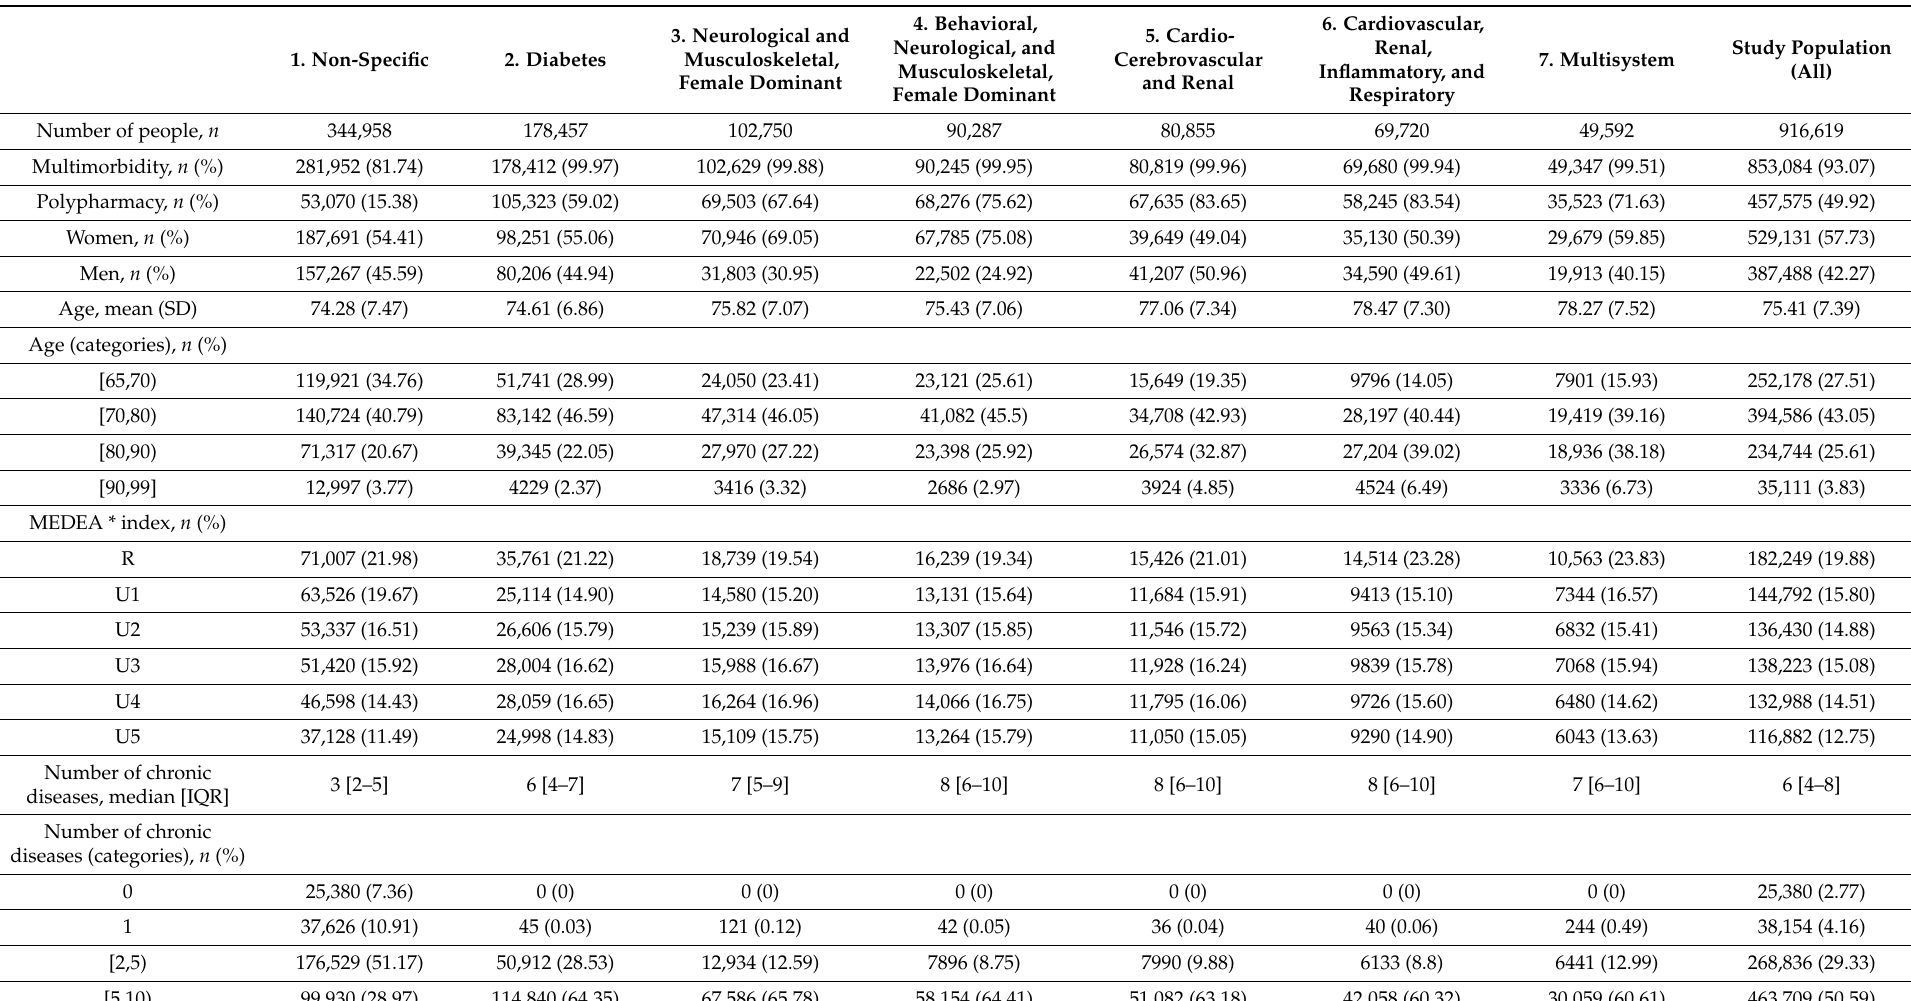
Table A4. Variables characterizing each cluster for chronic disease or chronic disease-drug category threshold of 2% ( n =